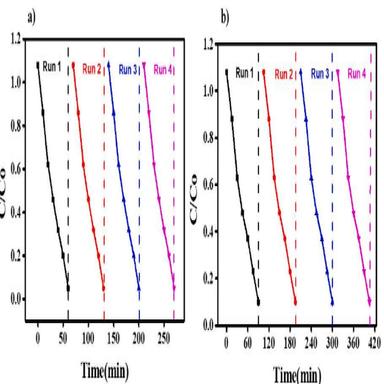
Efficiency of the NBO upon reusable with four cycles of photodegradation MB and MO dyes.